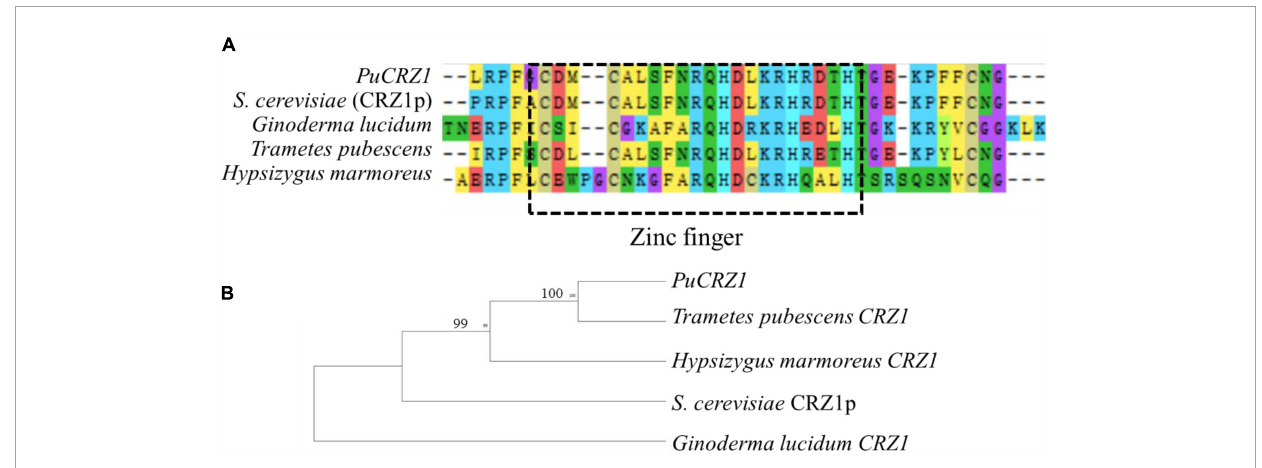
FIGURE1 Comparison of PuCRZ1 from P. umbellatus with other fungal homologs. (A) Amino acid sequence alignment PuCrz1 of P. umbellatus and homologs of CRZ1 from S. cerevisiae (CRZ1p), Ganoderma lucidum , Trametes pubescens , and Hypsizygus marmoreus . The box with the dashed line indicates the conserved C2H2 motif (C2H3-type domains). (B) Phylogenetic analysis of PuCZ1 and other homologs from other fungal species. The phylogenetic tree was constructed using MEGA 6.0 with full length of protein sequences and a neighbor-joining method with 1000 bootstrap